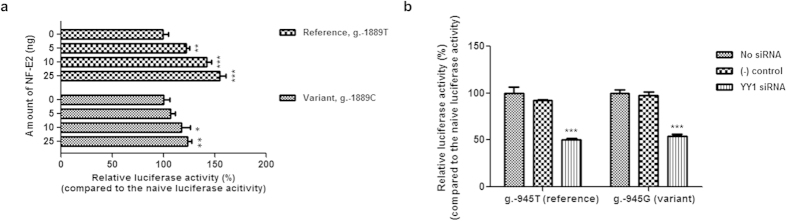
Effect of NF-E2 and YY1 on OCTN2 promoter activity.(a) Promoter activities were measured 48 hours after co-transfection of reference or variant plasmids and various amounts (0 to 25 ng) of NF-E2 into HCT-116 cells. The reporter activity of each construct was compared with naïve promoter activity without NF-E2. (b) Twenty-four hours after reverse transfection using siRNA for YY1, reference or variant luciferase constructs of OCTN2 promoter were co-transfected into HCT-116 cells. Forty-eight hours after the transfection, luciferase activities were measured. The reporter activity of each construct was compared with naïve promoter activity without siRNA. The data shown represent mean ± SD from triplicate wells in a representative experiment. *P < 0.05, **P < 0.01, ***P < 0.001 vs. naive promoter activity.